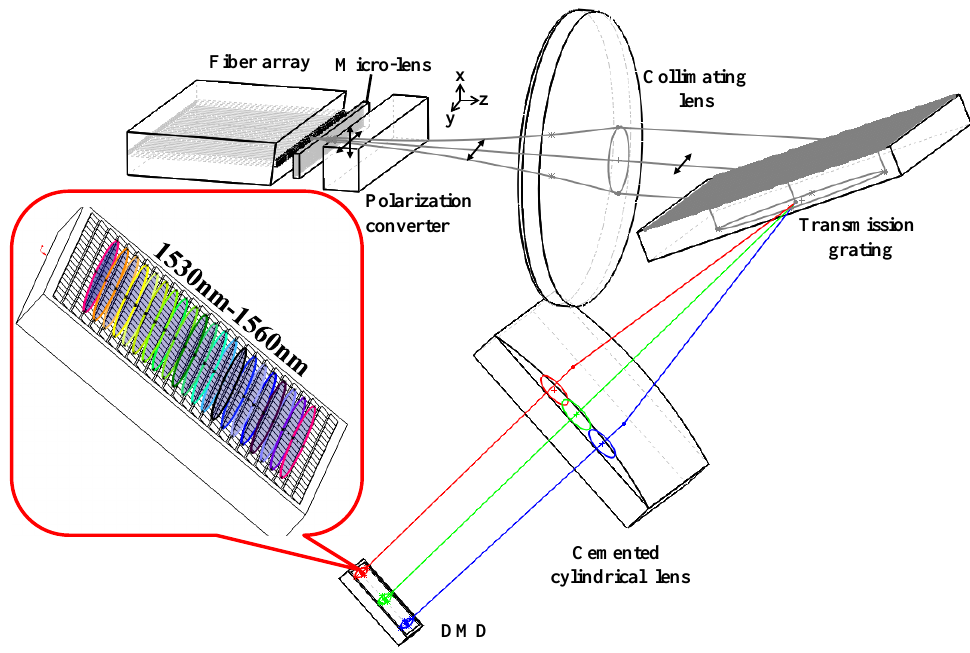
Figure 1. Diagram of programmable optical filter based on the digital micromirror device (DMD)